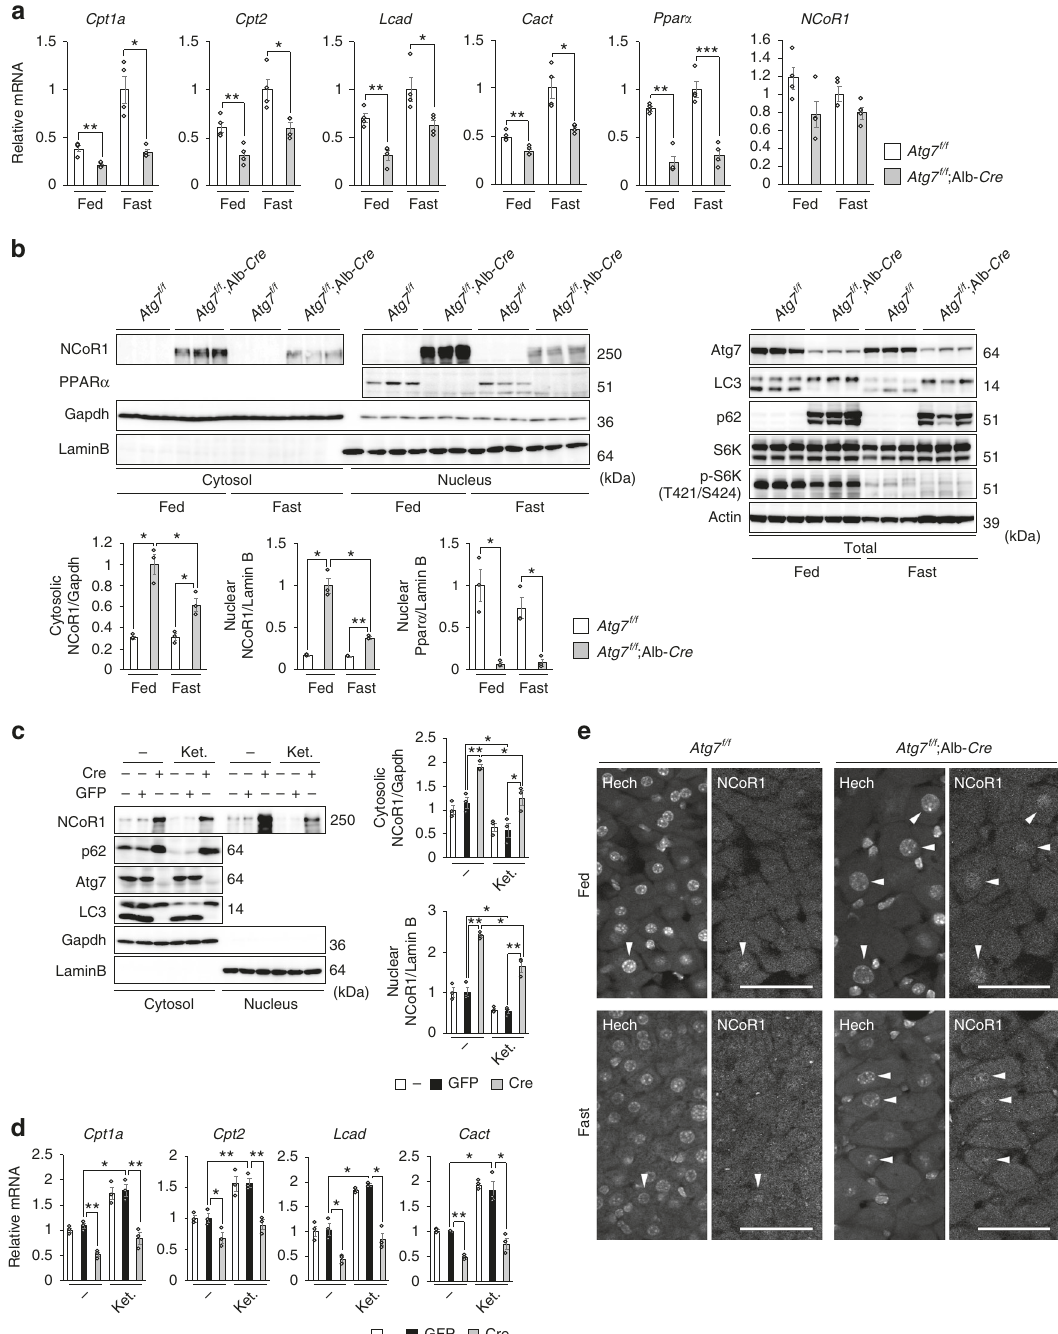
Fig. 2 Accumulation of NCoR1 and inactivation of PPAR α in autophagy-de fi cient livers. a Gene expression of enzymes related to lipid oxidation in Atg7 -de fi cient livers. Total RNAs were prepared from livers of Atg7 f/f ( n = 4) and Atg7 f/f ;Alb- Cre ( n = 4) mice aged at 5 weeks under both fed and fasting conditions. Values were normalized against the amount of mRNA in the livers of fasting Atg7 f/f mice. The experiments were performed three times. b PPAR α and NCoR1 level in Atg7 -de fi cient mouse livers. Total homogenate, as well as nuclear and cytoplasmic fractions, were prepared from livers of Atg7 f/f and Atg7 f/f ;Alb- Cre mice aged 5 weeks, and subjected to immunoblotting with the indicated antibodies. Bar graphs indicate the quantitative densitometric analyses of indicated cytoplasmic and nuclear proteins relative to Gapdh and Lamin B, respectively. c Immunoblot analysis. Primary hepatocytes were isolated from Atg7 f/f mice and infected with adenovirus for GFP or Cre-recombinase. Forty-eight hours after infection, the cells were cultured under nutrient-rich and ketogenic conditions for 24h, and then both nuclear and cytoplasmic fractions were prepared from the cells and subjected to immunoblotting with the indicated antibodies. Data are representative of three separate experiments. Bar graphs indicate the quantitative densitometric analyses of cytoplasmic and nuclear NCoR1 relative to Gapdh and Lamin B, respectively. d Total RNAs were prepared from cells described in c . Values were normalized against the amount of mRNA in adenovirus-uninfected Atg7 f/f primary hepatocytes. The experiments were performed three times. e Immunohisto fl uorescence microscopy. Liver sections of Atg7 f/f and Atg7 f/f ;Alb- Cre mice aged 5 weeks were immunostained with anti-NCoR1 antibody. Arrowheads indicate intranuclear signals for NCoR1. Bars: 50 μ m. Data are means±s.e.m. * P <0.05, ** P <0.01, and *** P <0.001 as determined by Welch ’ s t